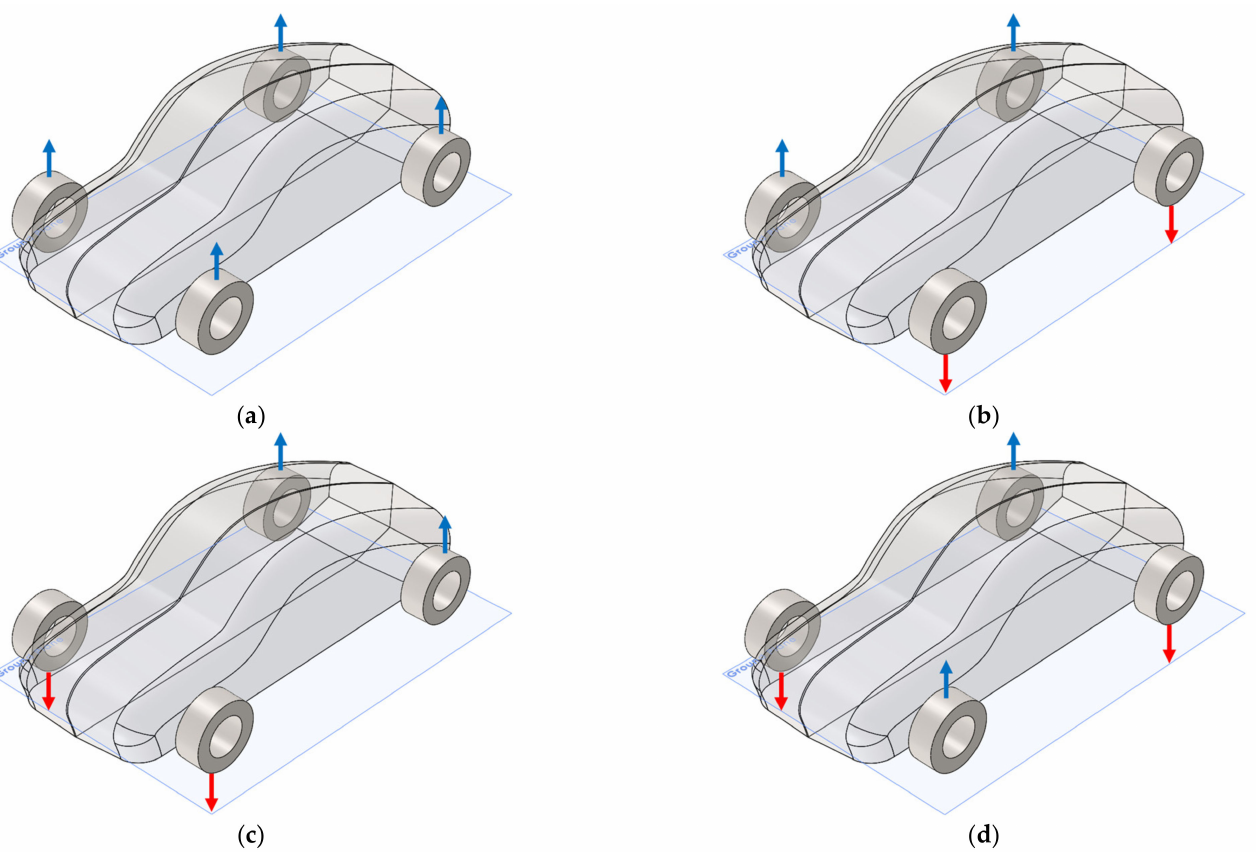
Figure 1. Modes of vibration. ( a ) Bounce, ( b ) roll, ( c ) pitch, and ( d )